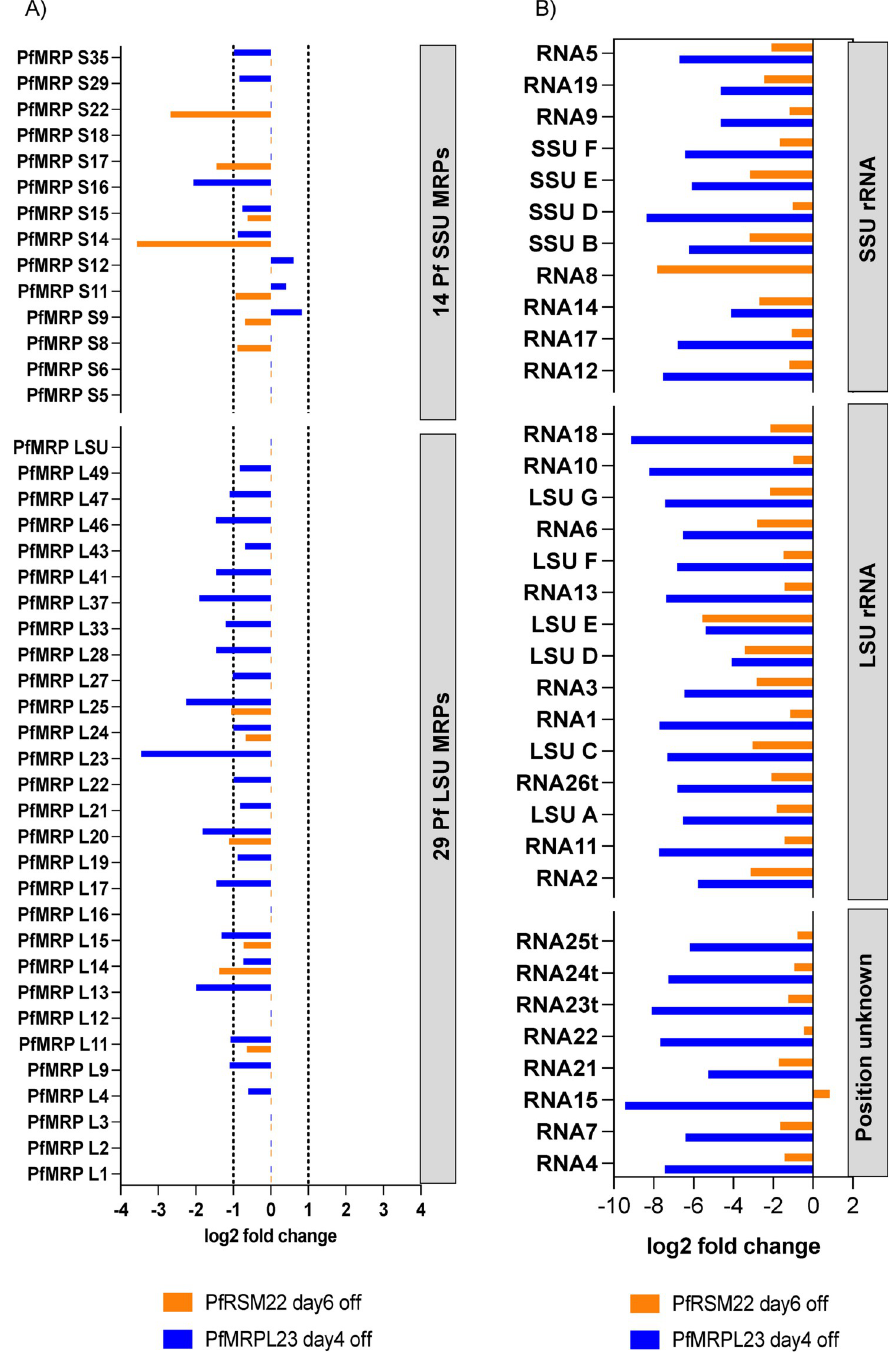
Fig 8. Late effects of PfRSM22 and PfMRPL23 KDs on transcripts of mitoribosomal components. (A) Log2 fold change of putative PfMRPs on day 6 after PfRSM22 KD (orange) and on day 4 after PfMRPL23 KD (blue). (B) Log2 fold change of mt rRNA fragments on day 6 after PfRSM22 KD (orange) and on day 4 after PfMRPL23 KD (blue).